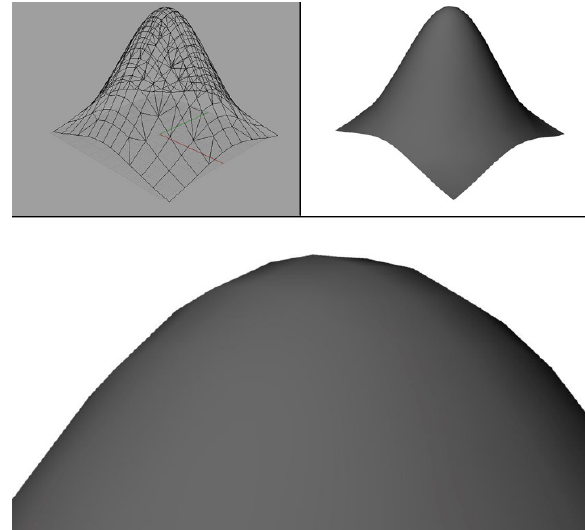
Figure 1. TIN models.